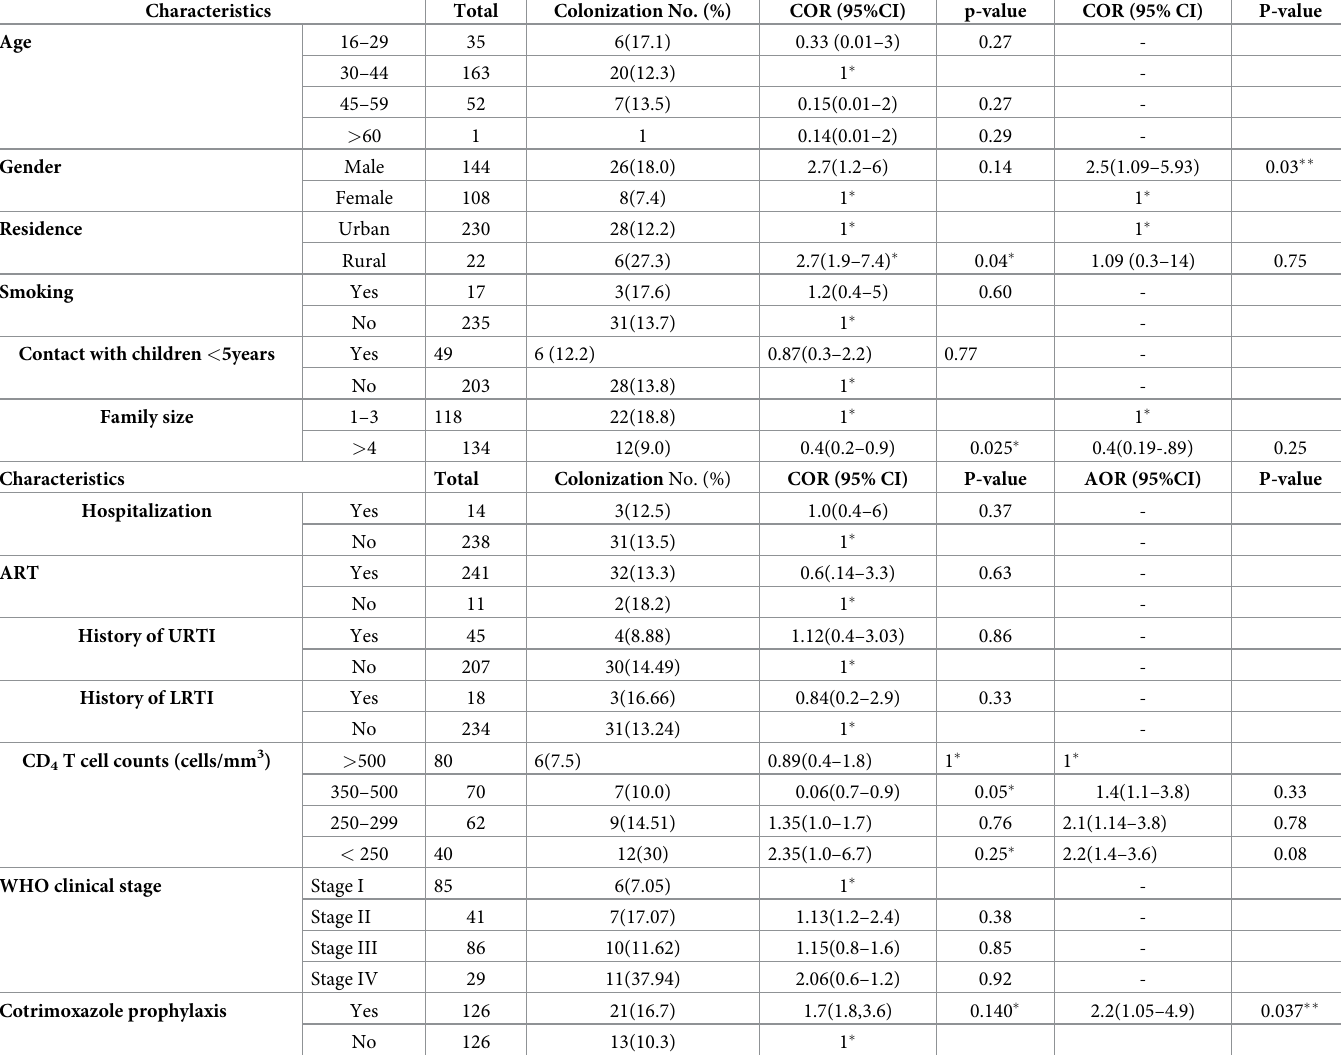
Table 2. Socio-demographic factors associated with pneumococcal colonization among HIV patients at Arba Minch Hospital, from April 01 to August 31, 2018 (n = 252).